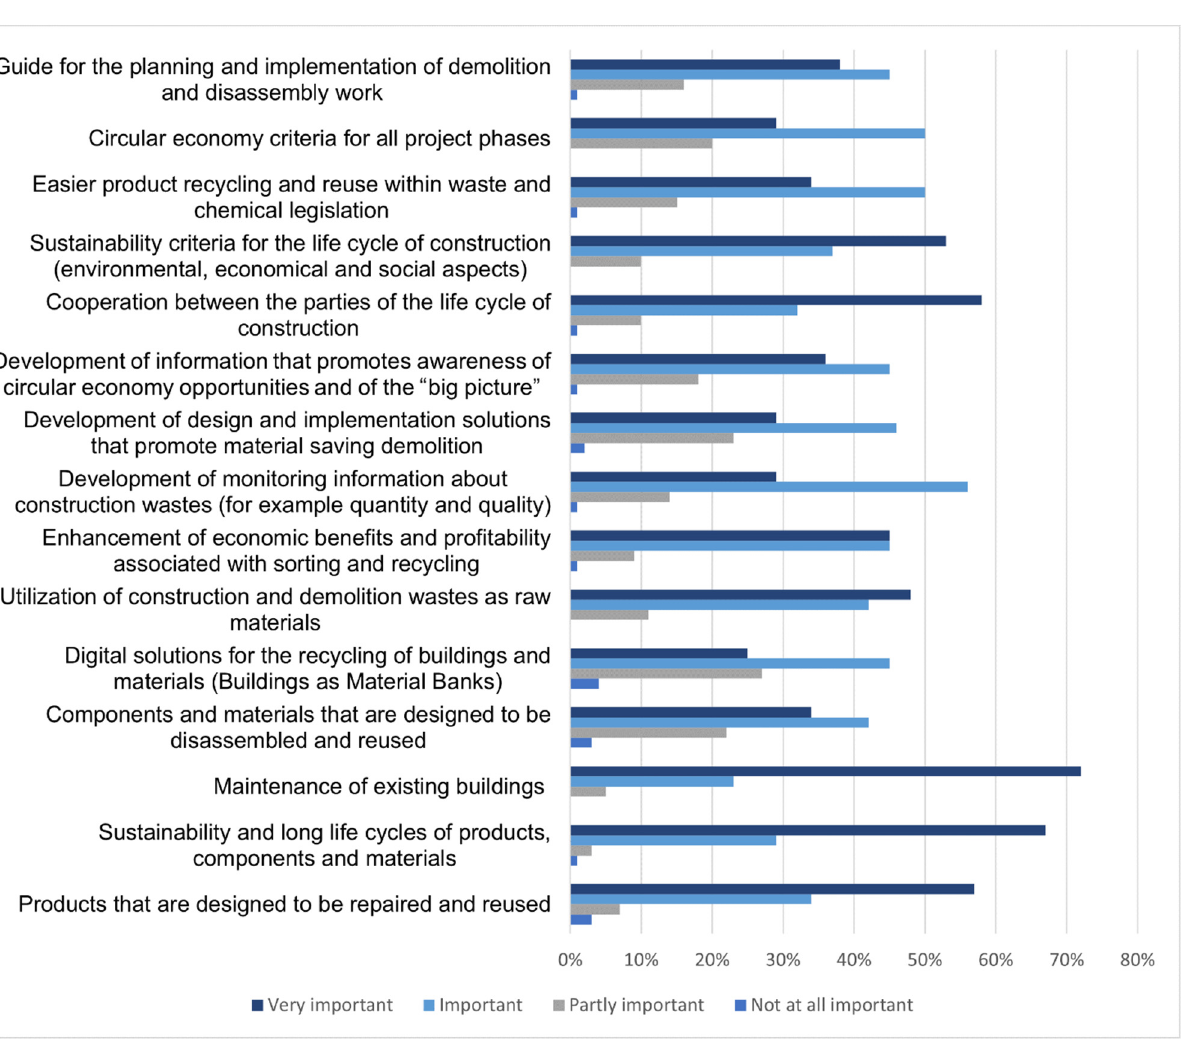
Figure 14. The importance of specific CE aspects in the construction sector.